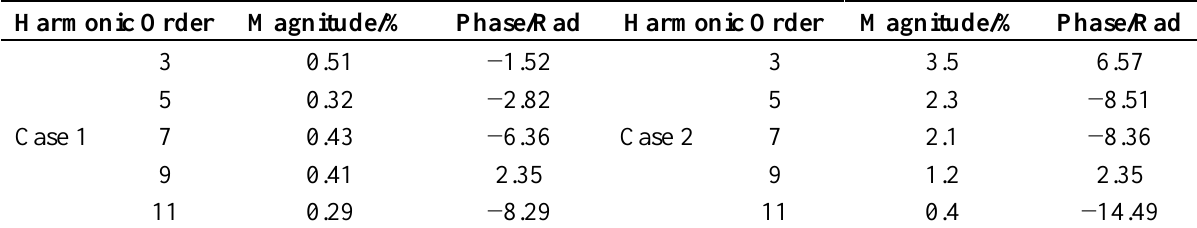
Table 1. Harmonic components of measured